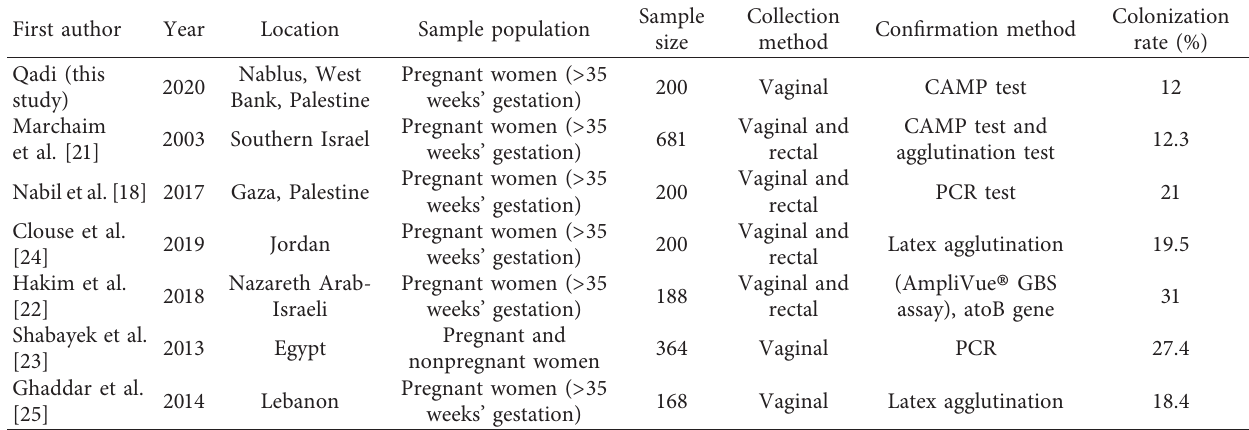
Table 5: Studies describing the GBS colonization rate in the vicinities of the West